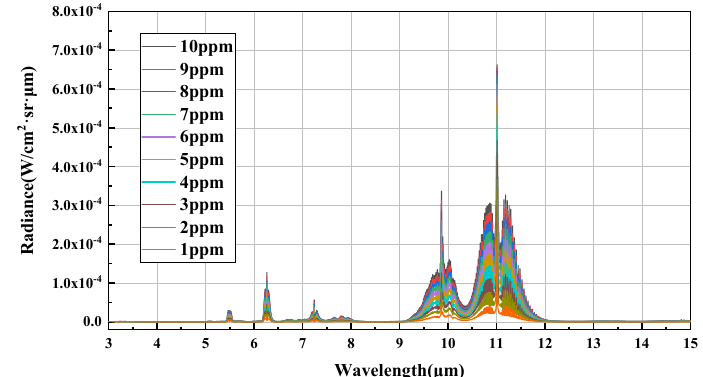
Figure 4. 1,3-butadiene infrared spectral radiance at 1–10 ppm.